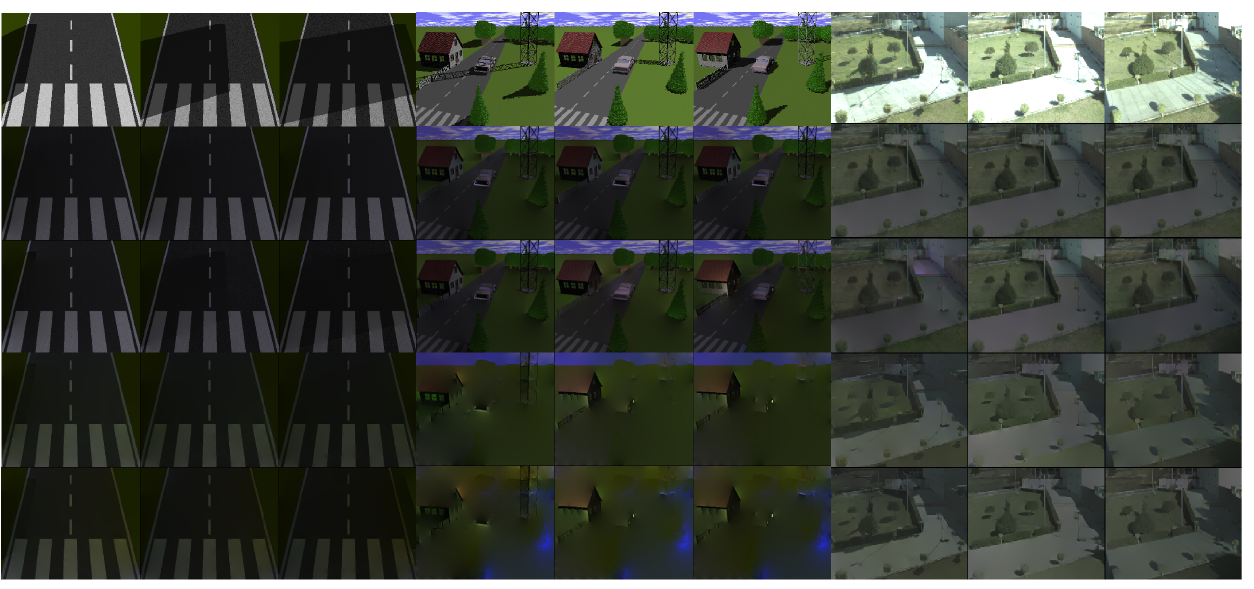
Figure 2. Reflectance images. Top, input images with different illumination conditions; second, third, fourth, and fifth rows are reflectance images computed with the Weiss